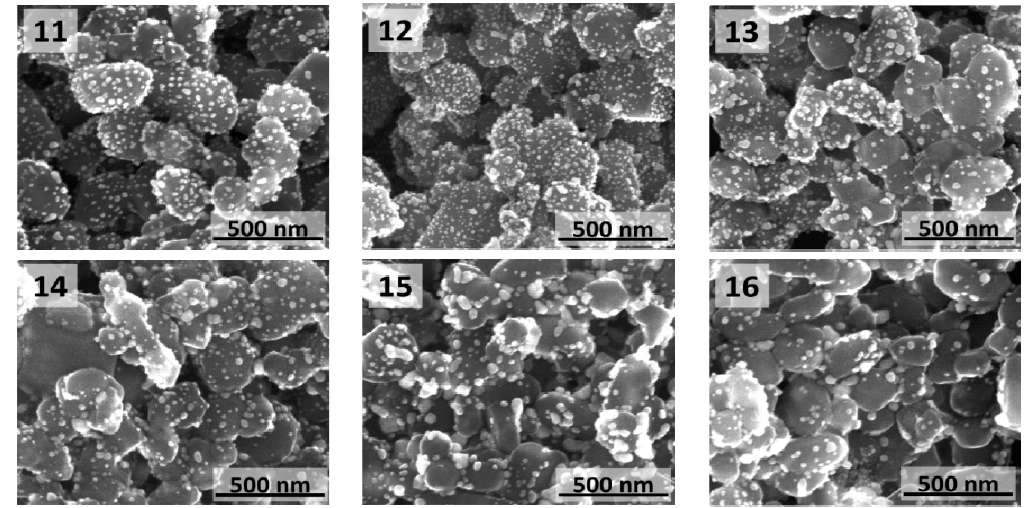
Figure 7. SEM images of TiO 2 @Au nanostructures obtained by direct reduction of gold salts on functionalized TiO 2 particles at various temperatures: ( 11 ) 100 °C; ( 12 ) 90 °C; ( 13 ) 80 °C; ( 14 ) 70 °C; ( 15 ) 60 °C; and ( 16 ) 50